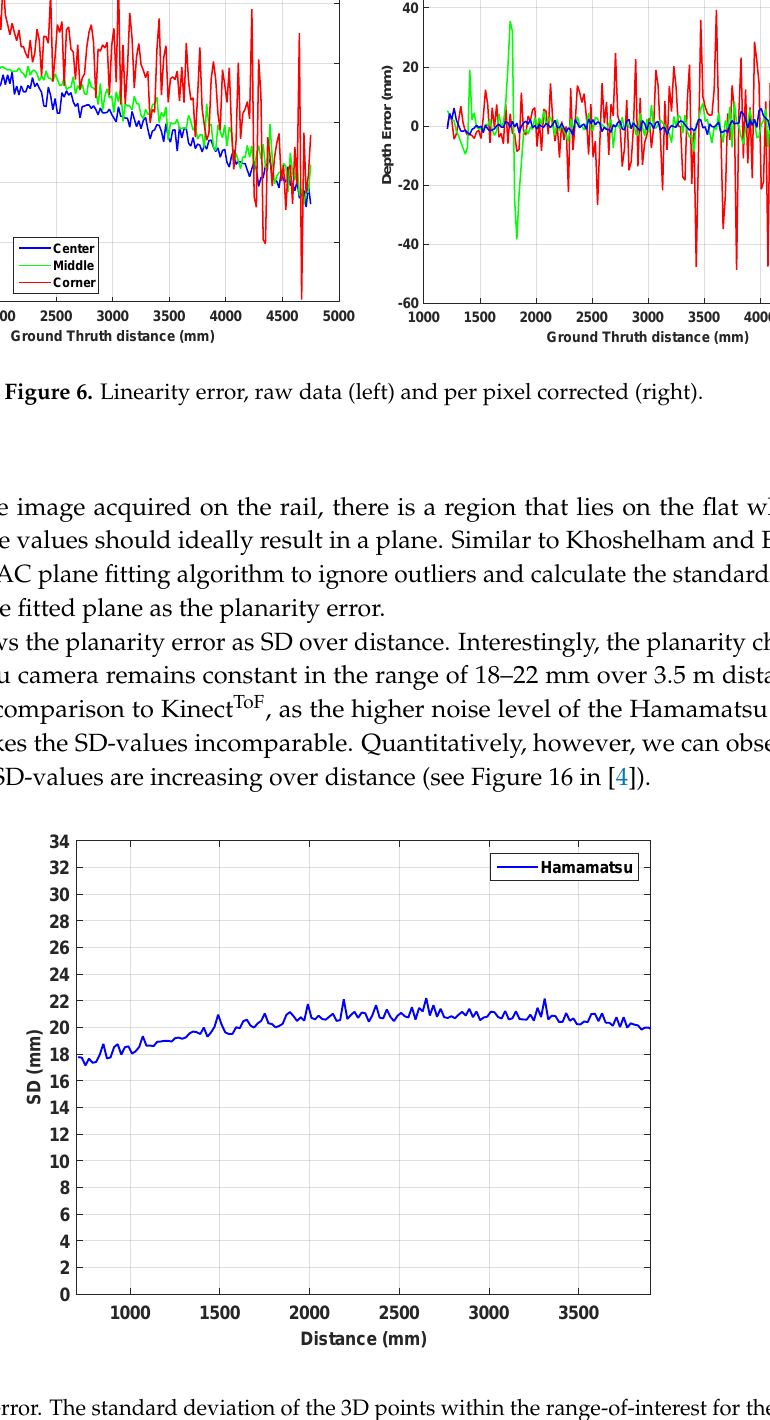
Figure 7. Planarity error. The standard deviation of the 3D points within the range-of-interest for the